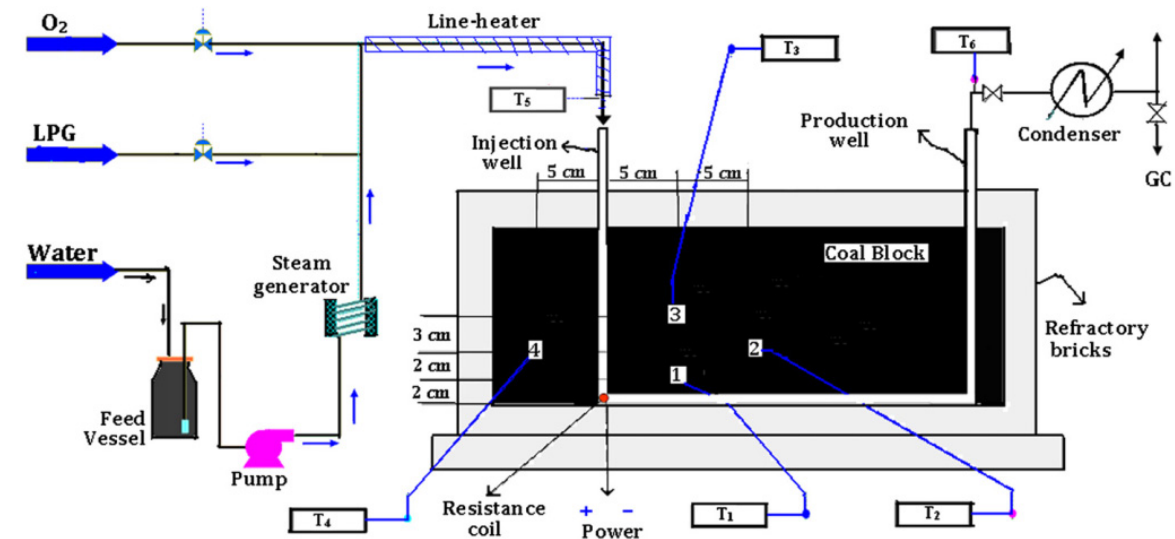
Figure 7. Experimental device for LVW technology (from [30,31]).